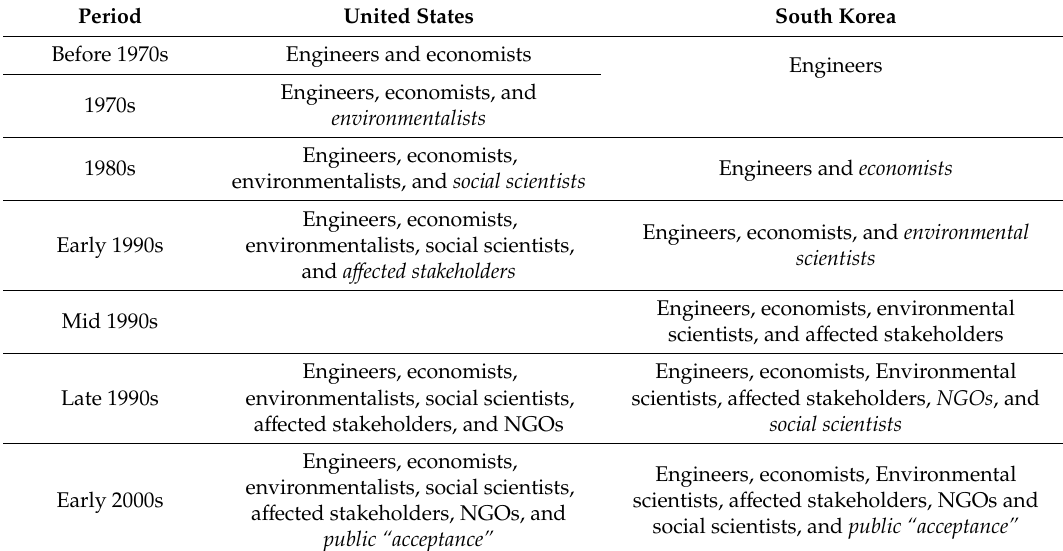
Table 1. Major key decision-makers in water resource management (U.S. vs.